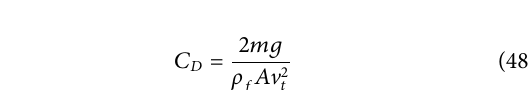
FIGURE 4 | Fluctuation range of C D and probability distribution of Re during particle parabolic